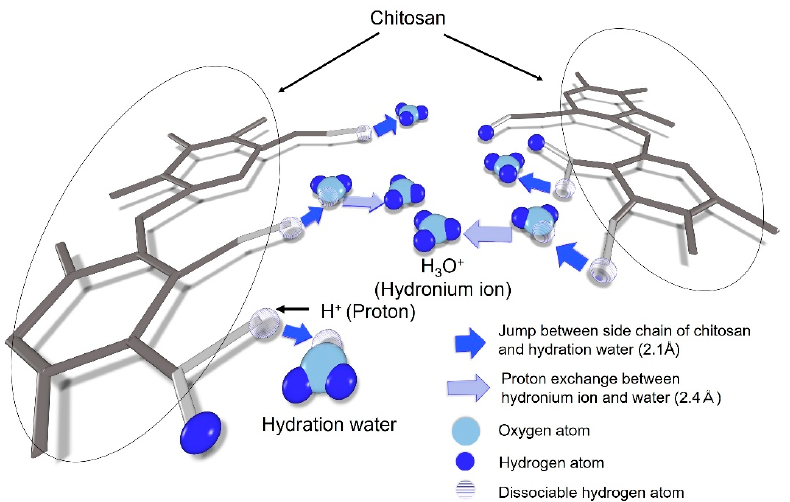
Figure 17. Schematic representation of the hydrogen dynamics in the vicinity of the chitosan chains in hydrated chitosan. Chitosan (dark gray), the side chains (hydroxyl and amino groups) of chitosan bearing dissociable hydrogen atoms (gray), the mobile hydration water (oxygen: light blue, hydrogen: blue), and the dissociated hydrogen atoms (translucent). The hydrogen atom of the chitosan amino group is dissociated as a proton and diffuses to a nearby hydration water molecule to form a hydronium ion. In addition, the hydrogen atoms of the hydroxyl groups are dissociated as protons and diffuse to nearby hydration water molecules followed by successive jumping to other water molecules to form hydronium